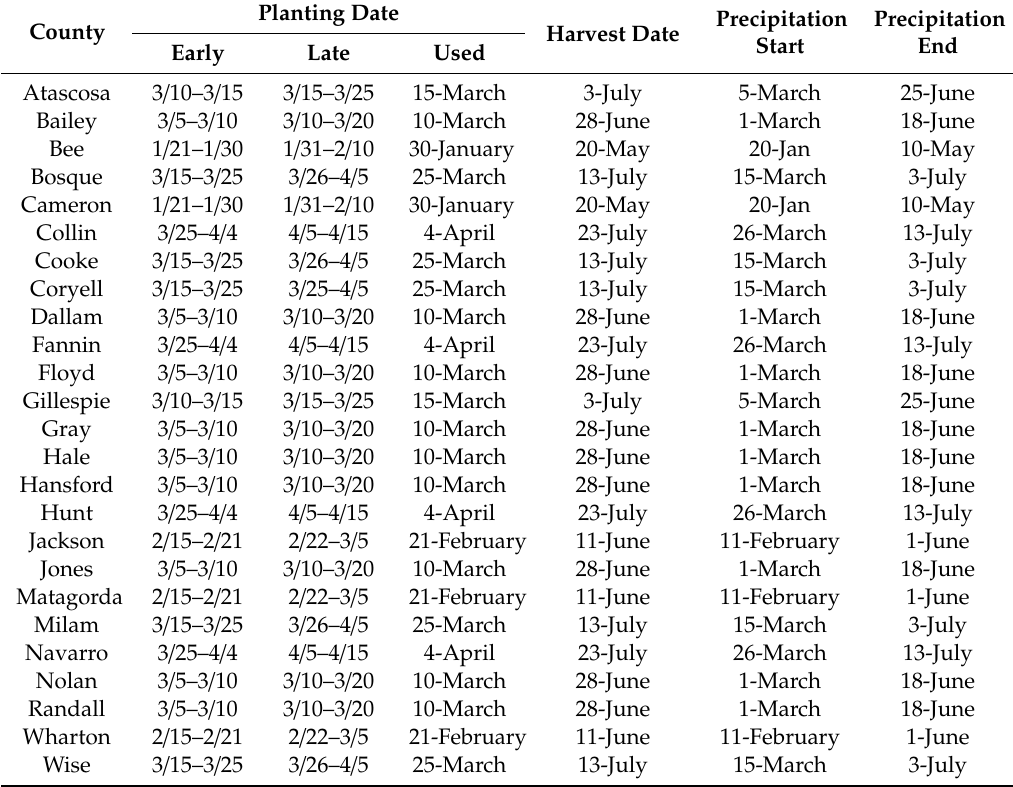
Figure 2. Estimation of growing season total precipitation and maximum 4-day total precipitation. Table 2. Plant date of sorghum in different counties of Texas [14].